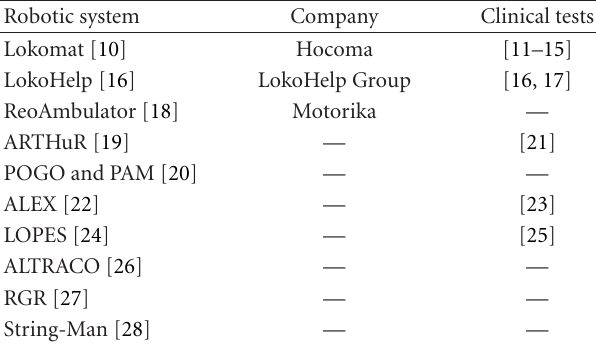
to review existing interfaces, as well as ongoing work, to show Table 1: Robotic systems for treadmill gait